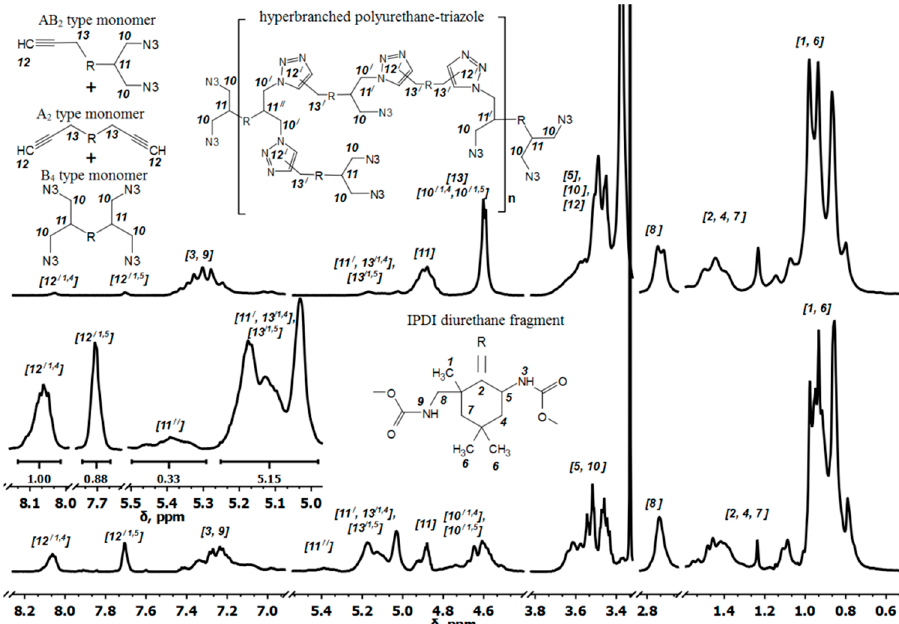
Figure 7. 1 H NMR spectra of AB 2 + A 2 + B 4 monomer mixture (top) and hyperbranched polyurethane-triazoles (bottom) in DMSO- d 6 . The ratio [NCO] 0 /[OH] 0 was 1.7.